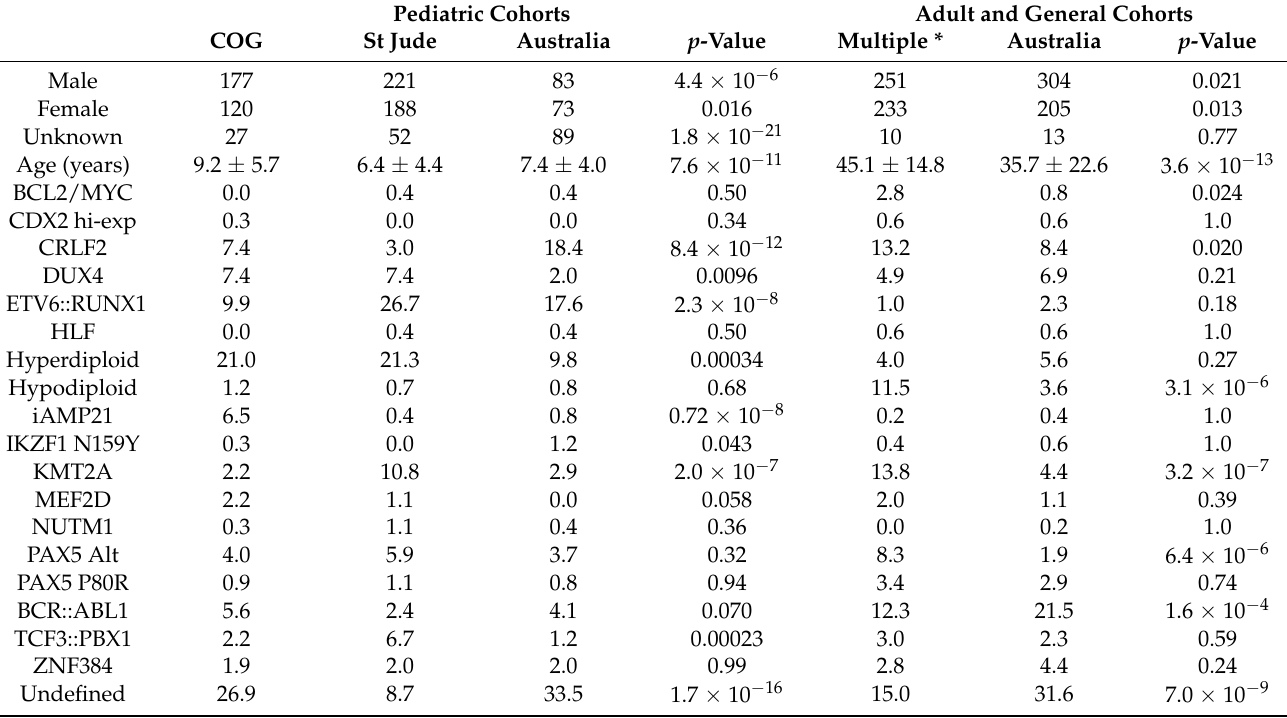
Table 1. Patient characteristics and frequencies (%) of ALL subtypes according to known genetic alterations. The participants were grouped primarily by the recruiting institute and secondarily by age (> 99% of participants in the pediatric cohorts were below 20 years of age). Mean and standard deviation are shown for age. p -values for cohort differences were calculated by the χ 2